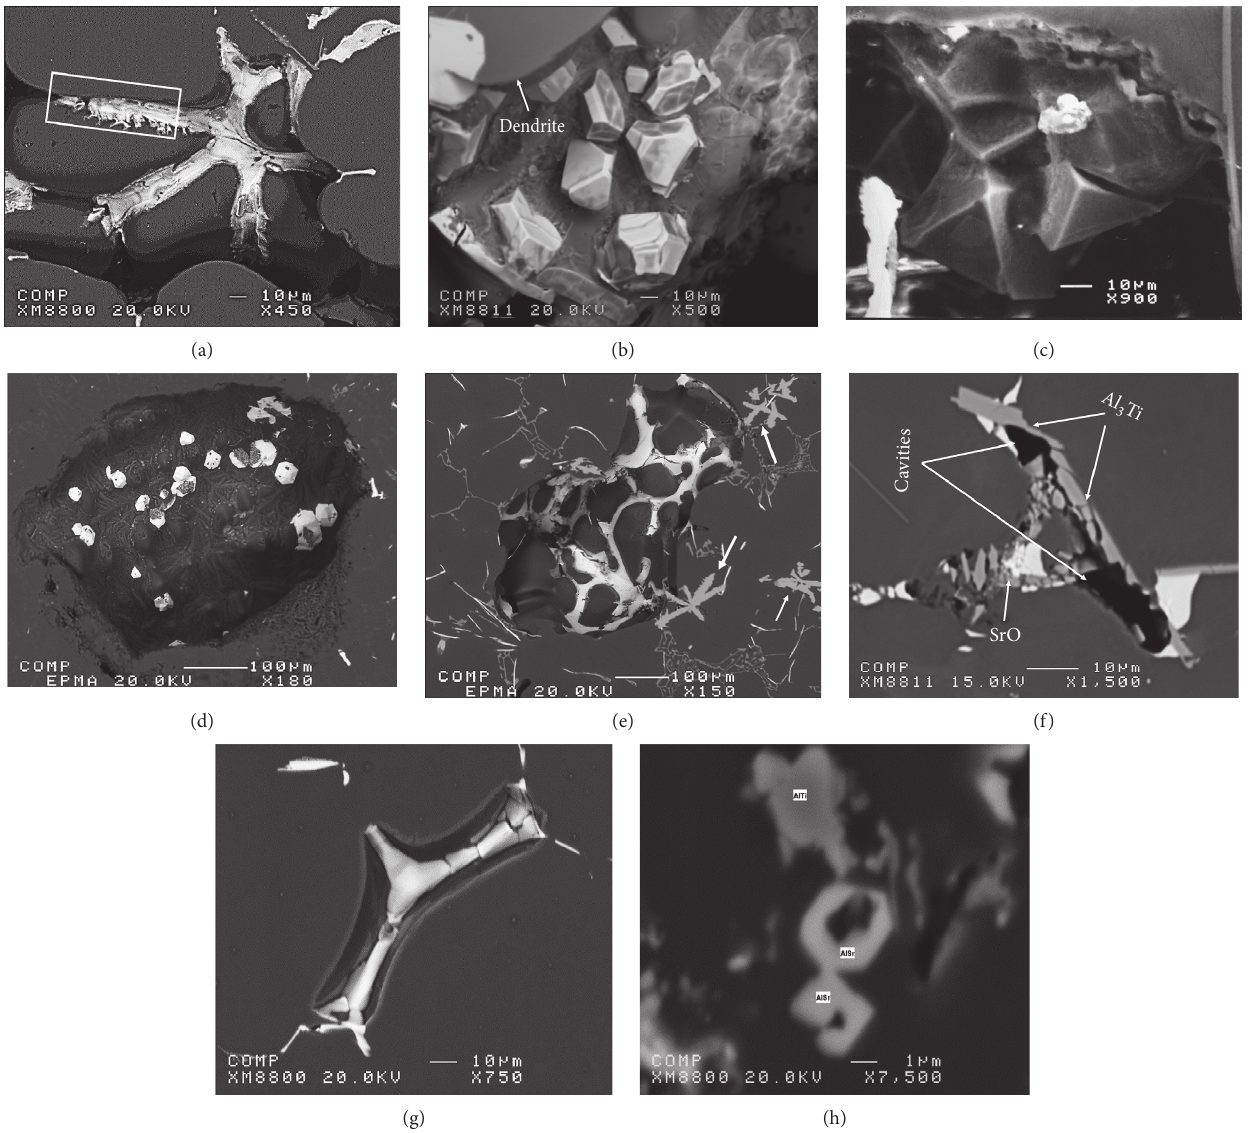
Figure 17: Backscattered electron images of porosity occurring due to precipitation of high temperature compounds: (a) Mg note: the presence of Mg 2 Sn arm lying within the dendrites (white rectangle), (b–d) Al 2 Si 2 Sr particles, (e) high Ti-containing RE in- termetallic-note the absence of cavities around the star-like particles as indicated by the white arrows, (f) segregation of Al 3 Ti phase particles, (g) precipitation of massive AlTiBSr phase particles, (h) precipitation of both AlTi and AlSr